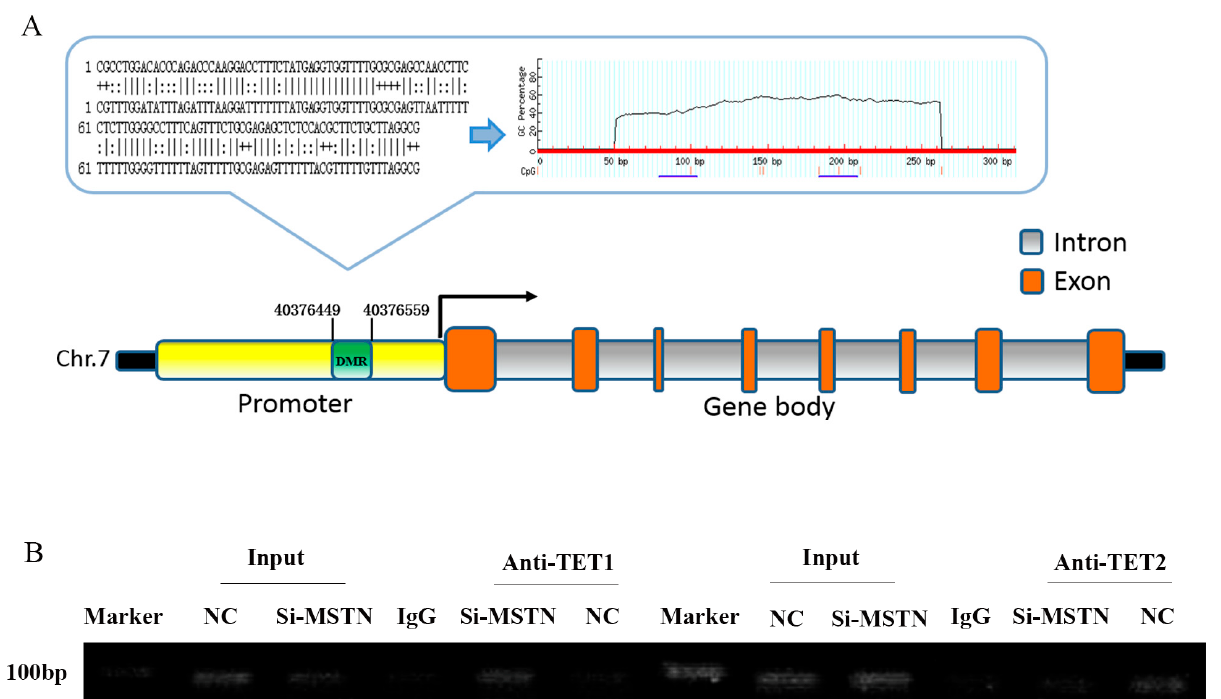
Figure 5. RACK1 and DNA demethylation. ( A ) Schematic representation of the DMR of the RACK1 gene. ( B ) ChIP verifies the binding of the TET1/TET2 protein to the DMR of RACK1.